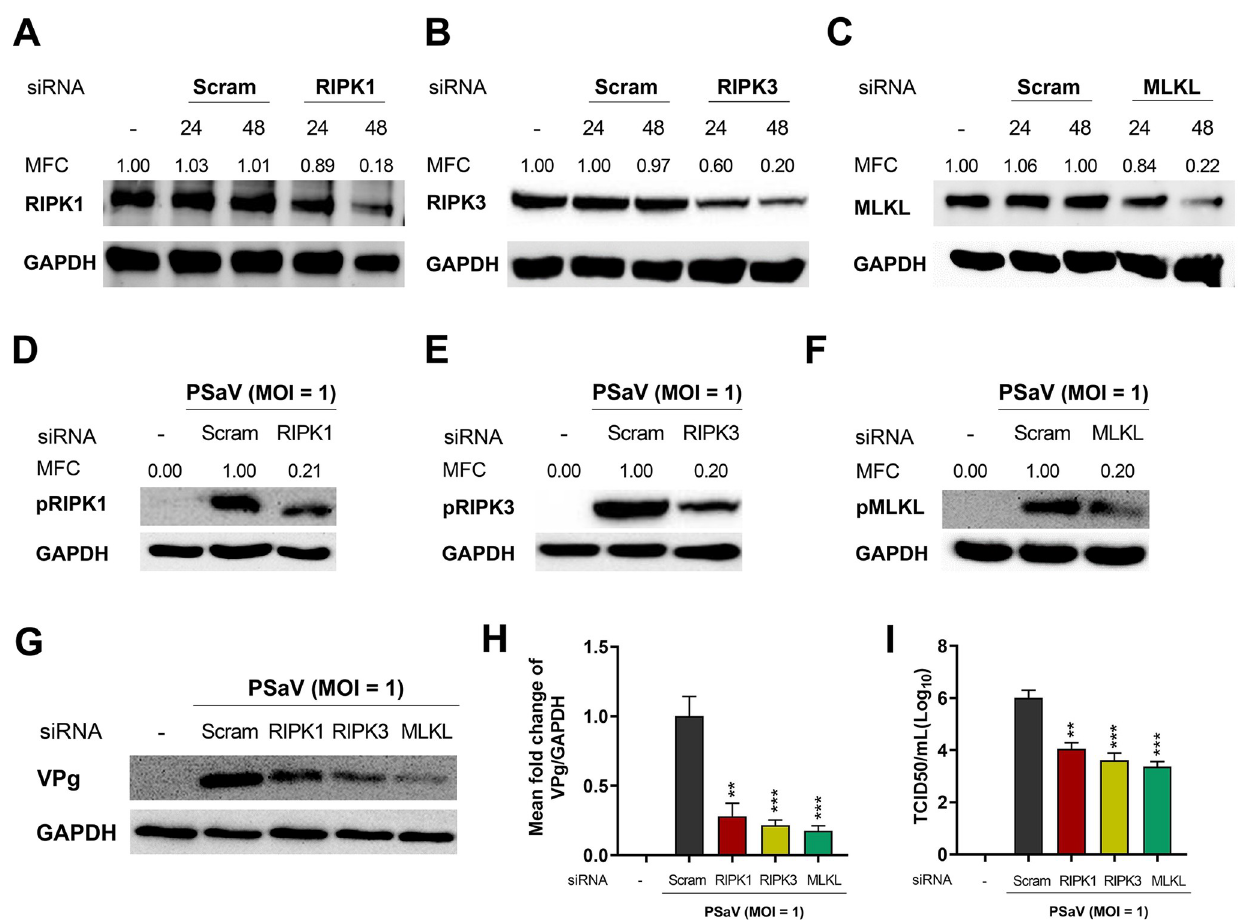
Fig 7. Silencing of necroptosis molecules in LLC-PK cells inhibits PSaV replication. (A-C) Mock-infected LLC-PK cells were transfected with either scrambled siRNA or siRNAs against RIPK1 (A), RIPK3 (B), or MLKL (C) and incubated in the presence of 200 μ M GCDCA for 24 and 48 h. RIPK1, RIPK3, or MLKL protein levels were evaluated via western blot analysis. GAPDH was used as a loading control. (D-F) The transfected cells with either scrambled siRNA or siRNAs against RIPK1, RIPK3, or MLKL were infected with PSaV Cowden strain (MOI = 1 TCID 50 ) and incubated in the presence of 200 μ M GCDCA for 24 h. The cell lysates were subjected to western blotting to determine pRIPK1, pRIPK3, and pMLKL, respectively. GAPDH was used as a loading control. (G) PSaV VPg protein levels in the cells described in panels D-F were determined by western blotting. GAPDH was used as a loading control. (H) The relative expression of PSaV VPg (in panel G) was determined via densitometric analysis. (I) The viral titer was determined using TCID 50 assay. Data are presented as means ± standard errors from two independent experiments. Differences were evaluated using one - way ANOVA. �� p < 0.01; ��� p < 0.001.